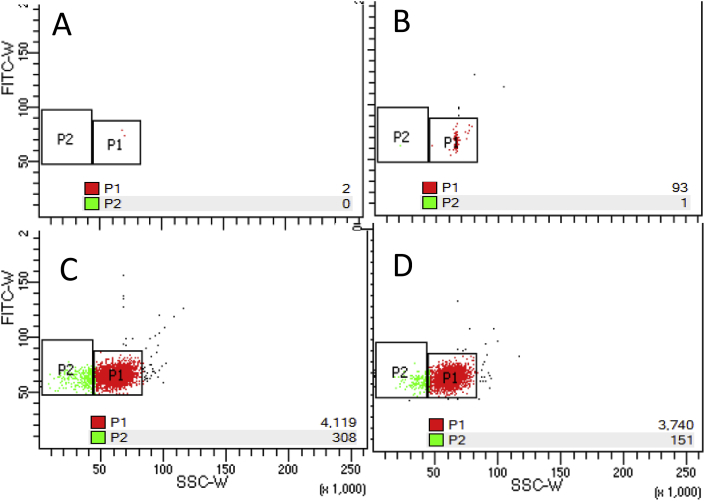
FCM fluorescent signal of 0.5x SYBR® Green I in TE. No SYBR TE control (A), gently handled sample (B), and the same sample immediately and 10 min after vigorous pipetting (C and D). P1 – gated SYBR particle population, P2 – gate based on T4 virus signal. Immediately after pipetting SYBR population overlapped with the P2 gate. (For interpretation of the references to colour in this figure legend, the reader is referred to the Web version of this article.)